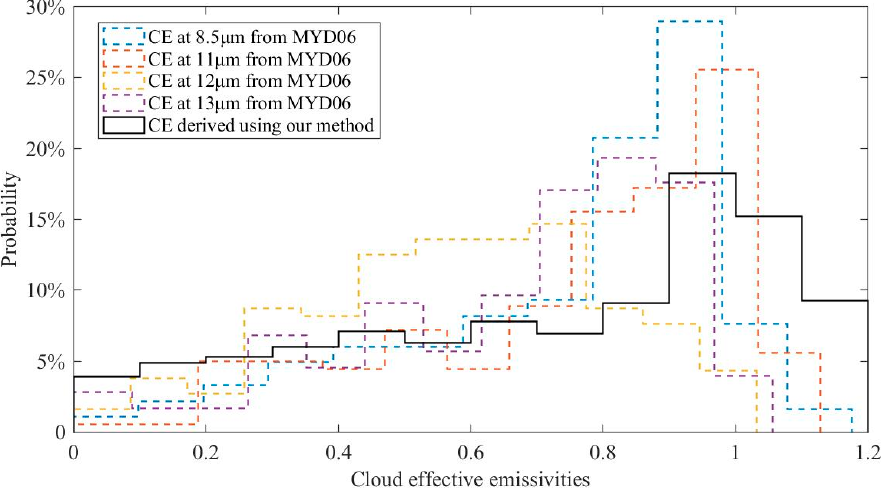
Figure 6. Histograms of cloud effective emissivities comparing the distribution from the derived from the MODIS/AQUA MYD06 C6 data and from the present data.